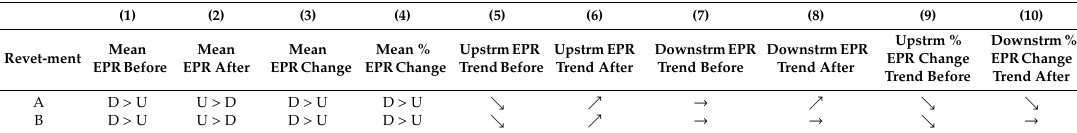
Table 14. Summarized results of erosion patterns for transects located within 1 km of revetment terminal ends (D = downstream, U =